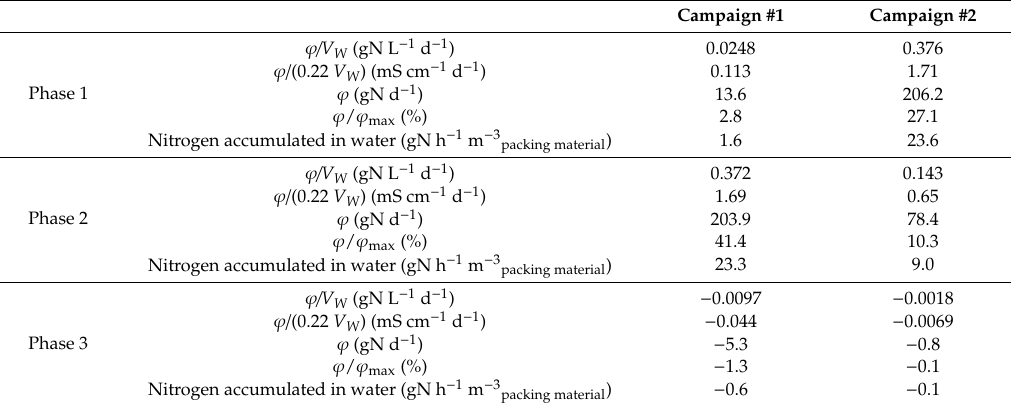
Table 2. Main results calculated for campaigns #1 and